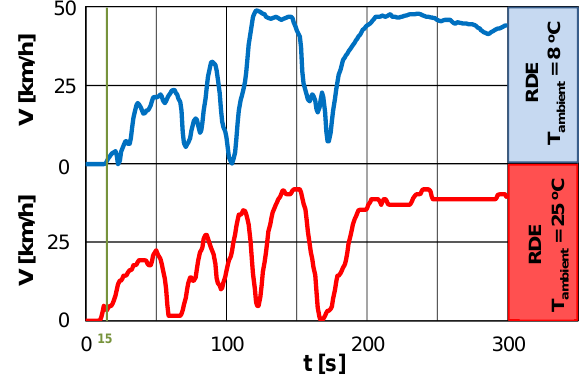
Fig. 4. Vehicle speed during the cold start phase at different ambient